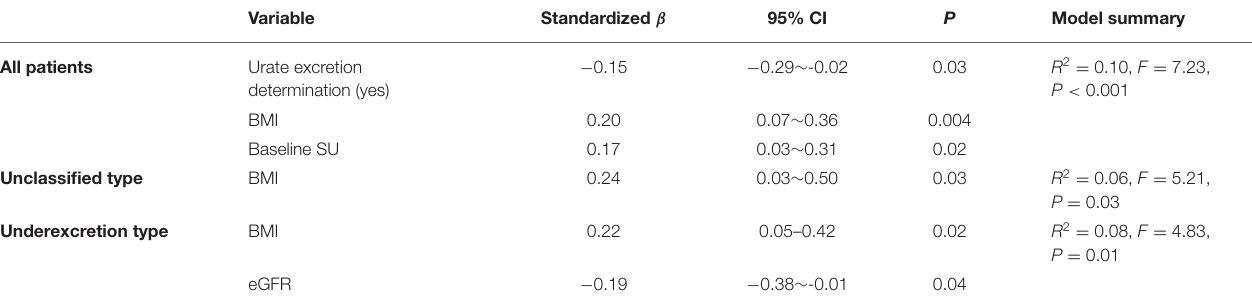
TABLE 3 | Predictors of serum urate on the 12-week in linear regression analysis.